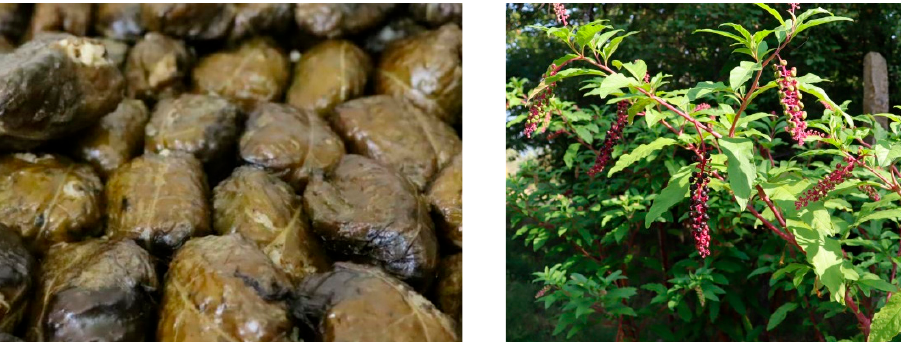
Figure 7. Phytolacca americana L. is used diversely throughout the season—leaves are used for preparation of sarmi ( left ) and the fruits ( right ) for color fortification of wines and as ink in the past (Gabrene village, Blagoevgrad Province).